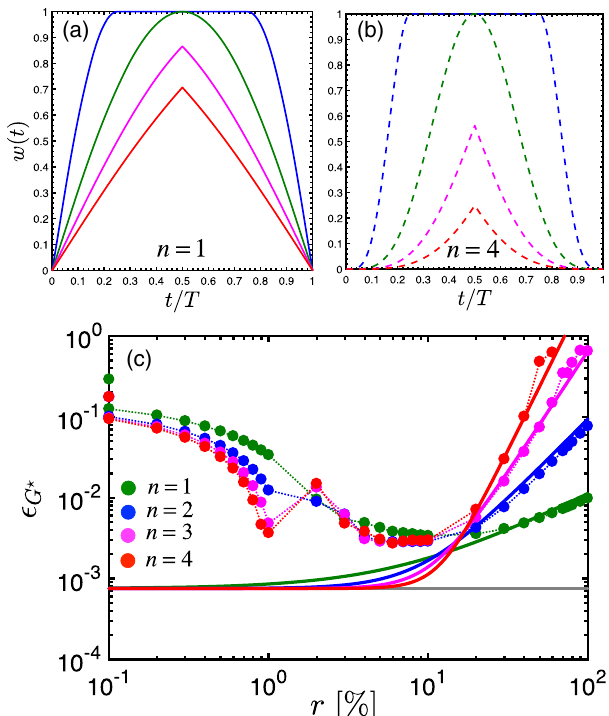
FIG. 6. The window function w ð t Þ is plotted for Tukey windows with (a) n ¼ 1 and (b) n ¼ 4 . The different blue, green, magenta, and red colors correspond to r ¼ 50% (blue line), r ¼ 100% (green line), r ¼ 150% (magenta line), and r ¼ 200% (red line), respectively. (c) The computed errors for the complex modulus, from numerical simulations, are plotted versus the tapering parameter r for different Tukey windows: n ¼ 1 (green dot filled circle), n ¼ 2 (blue dot filled circle), n ¼ 3 (magenta dot filled circle), and n ¼ 4 (red dot filled circle). The corresponding solid lines show the error predictions from Eq. (B4) with c 1 ¼ 0 . 3 and c 2 ¼ 0 . 126 . The gray line represents the case of n ¼ 0